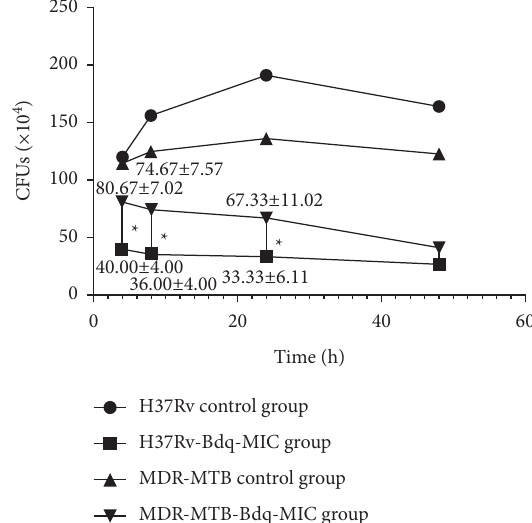
Figure 1: Intracellular CFUs detected in macrophages infected with H37Rv and MDR-MTB strains after Bdq